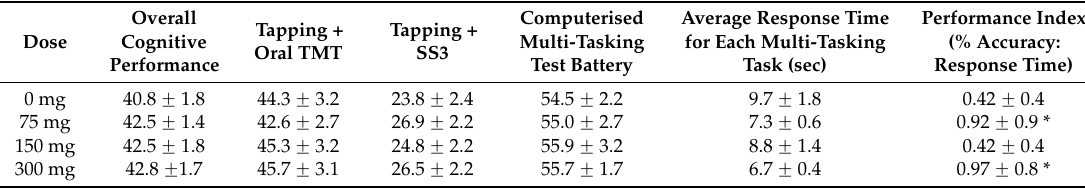
Table 1 . Overall cognitive performance is calculated as the average percentage accuracy from dual tasking and computerized multi ‐ tasking test battery. The performance index to the computerized multi ‐ tasking test battery is determined by the ratio of the accuracy and response time taken for each task in the multi ‐ tasking battery, where a higher value equates to better performance. Data are shown as mean ± SEM. * P < 0.001 compared to placebo.